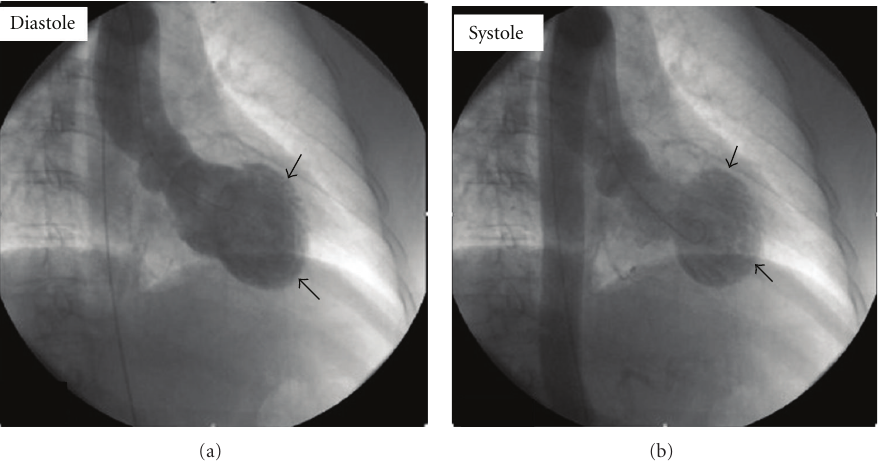
Figure 3: Diastolic and systolic frames from left ventriculography of a patient with akinesis of midsegment and normal apical contraction (recurrent stress-induced cardiomyopathy after a gap of 5